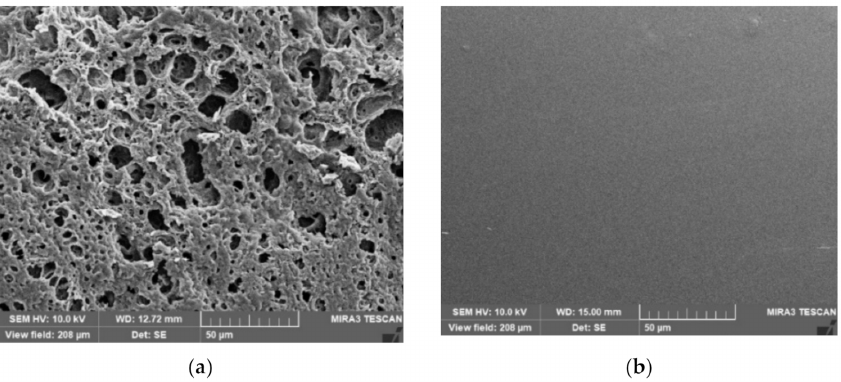
Figure 7. SEM images of DH-loaded rosin in situ forming gel after release test for ten days; ( a ) DHRL0 and ( b ) DHRL2.5 with 1000 ×